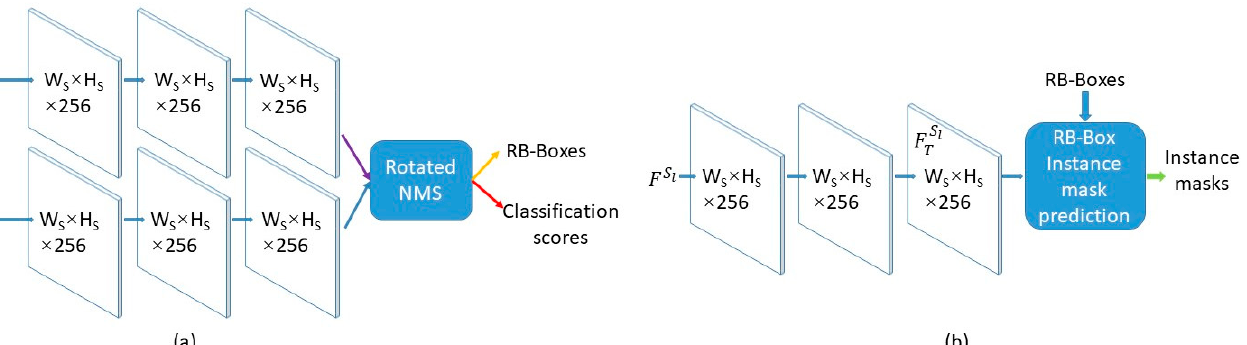
Figure 6. Overviews of the DetHead ( a ) and the MaskHead ( b ). In ( a ), F S two different three-layer convolutional networks to predict the RB-Boxes and their classification scores. Then the rotated NMS algorithm produces the final results. In ( b ), with the F S l as input, the feature map, F S l , output from a three-layer convolutional network and the RB-Boxes is used to produce the final instance masks by the RB-Box instance mask